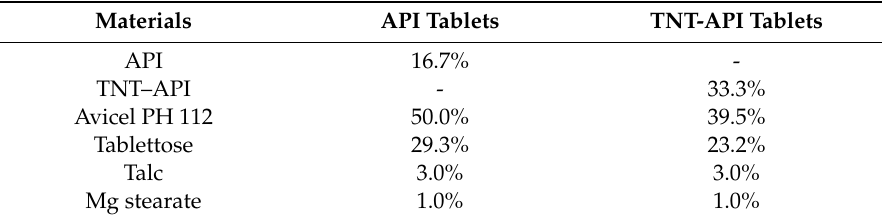
Table 1. Compositions of active pharmaceutical ingredient (API) and titanate nanotube (TNT)–API